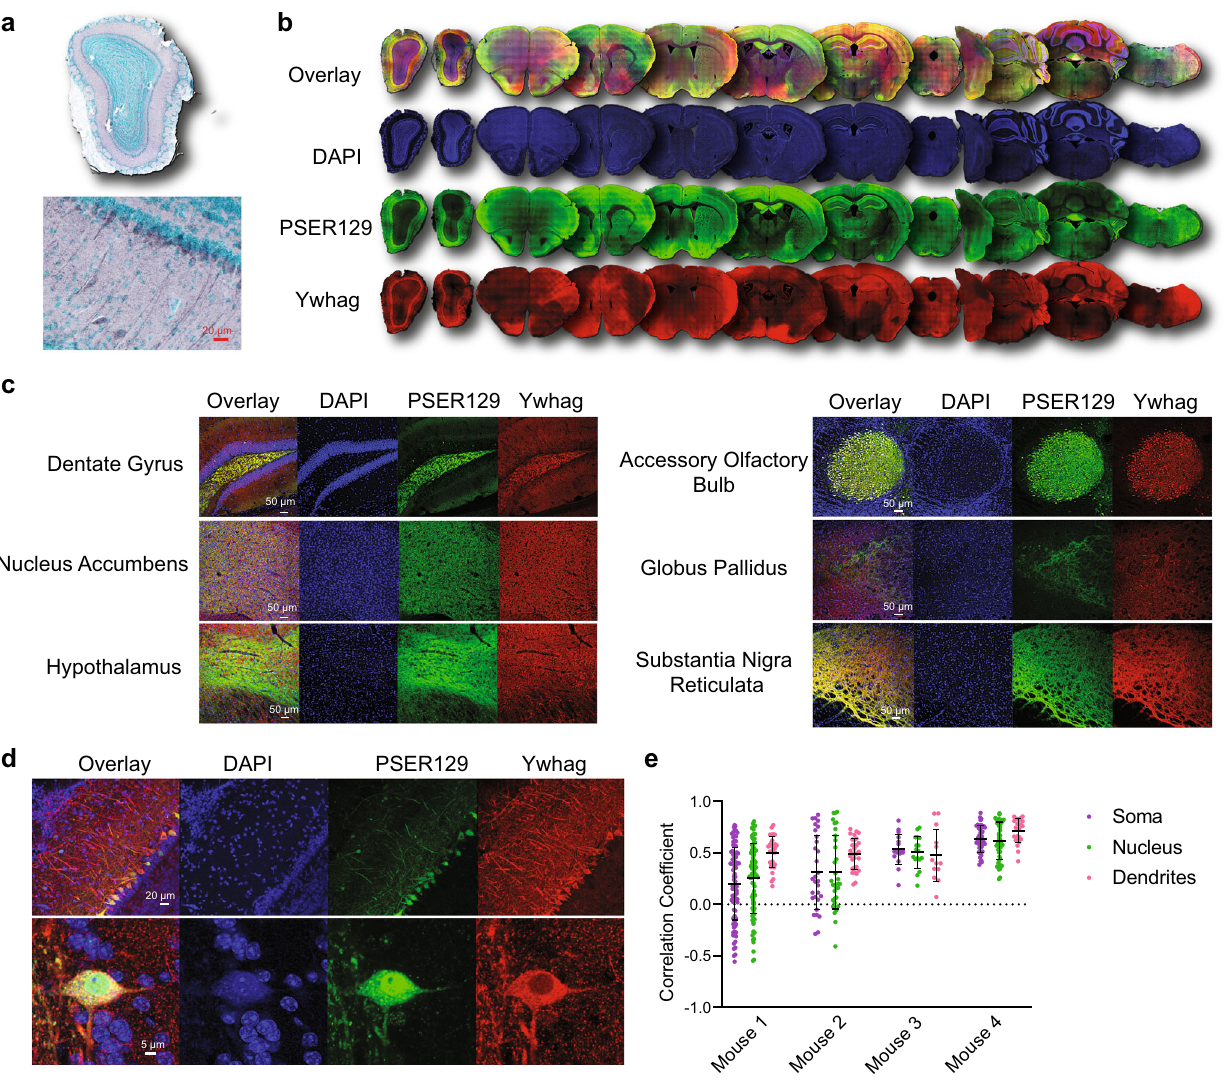
Fig. 7 BAR-PSER129 identi fi ed protein Ywhag associated with PSER129 across the neuroaxis. a IHC detection of Ywhag in the WT mouse OB. b Whole section scans of dual-labeled Ywhag and PSER129 across the neuroaxis of a healthy mouse. c High-magni fi cation confocal images of Ywhag and PSER129 in select brain regions. d High-magni fi cation confocal images of Ywhag and PSER129 in the mitral cell layer. e Colocalization analysis of mitral cells. Pearson ’ s correlation coef fi cient was calculated in the soma, nucleus, and dendrites of PSER129 positive mitral cells. (mean ± SD, WT mice, n =